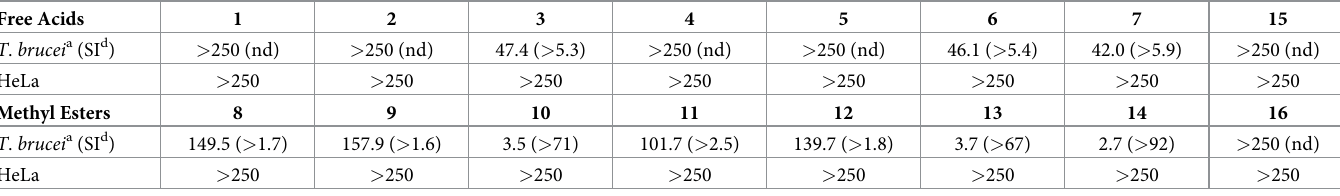
Table 1. Bioactivity of tryptophan derivatives 1–7 and their methyl esters 8–14, as well as natural tryptophan (15) and its methyl ester 16, against T . brucei blood- stream form trypomastigotes and HeLa cells. Mean half maximal growth inhibition (EC 50 ) values ( μ M) determined from n = 4 replicates, all SD values (not shown) were within 10% of each EC 50 value. nd-not